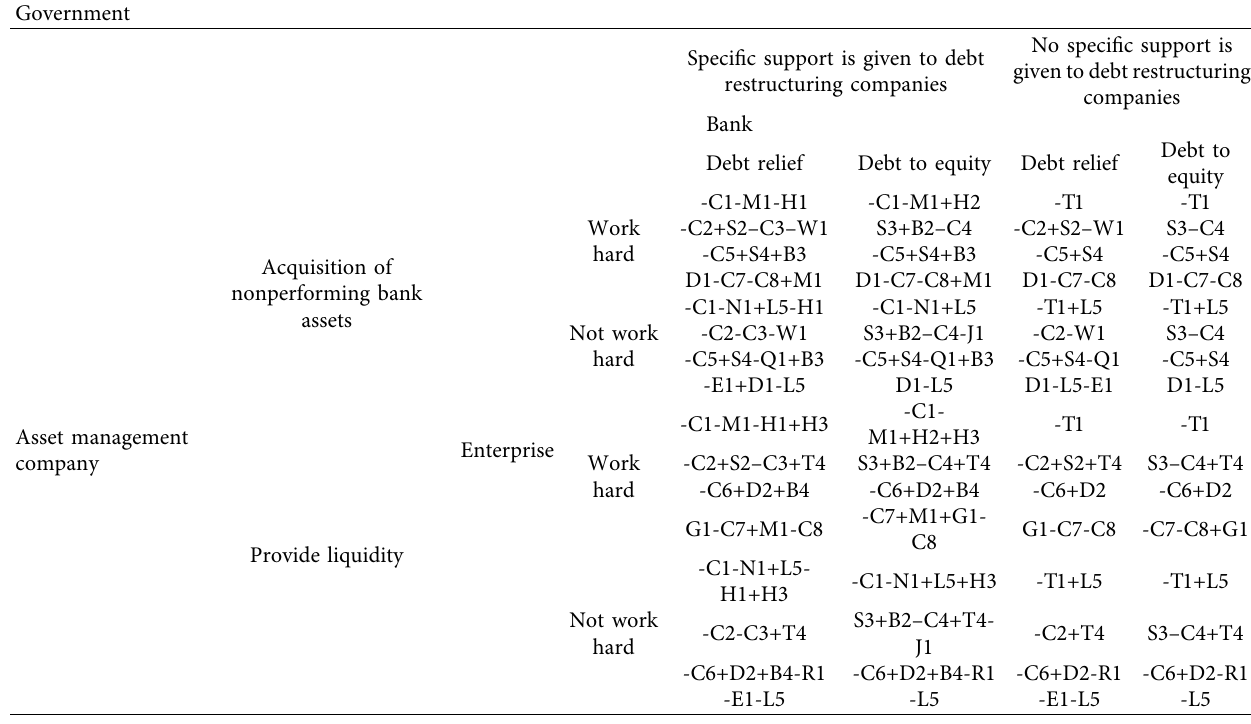
Table 1: Quartet evolutionary game payoff matrix of debt